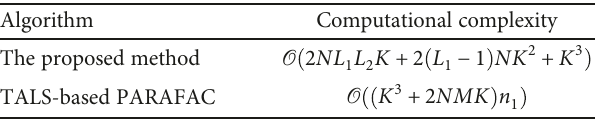
Table 1: Computational complexity of the proposed algorithm and TALS-based PARAFAC. Algorithm Computational complexity The proposed method TALS-based